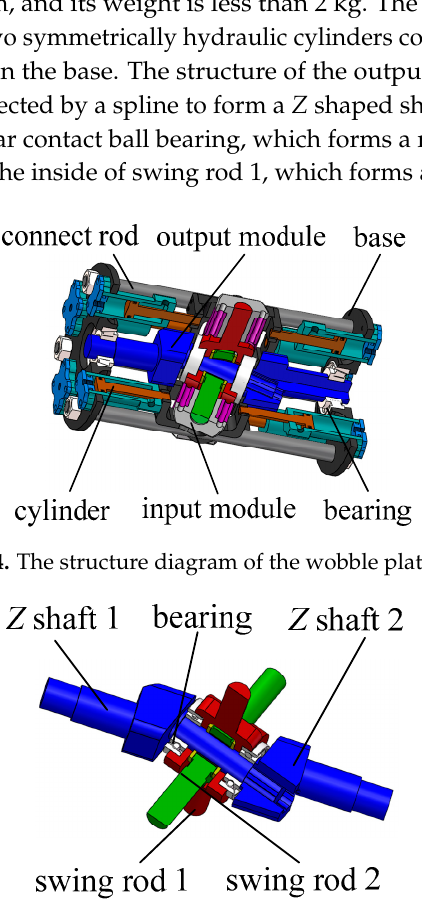
Figure 3. The diagram of the mobile manipulator hydraulic system.